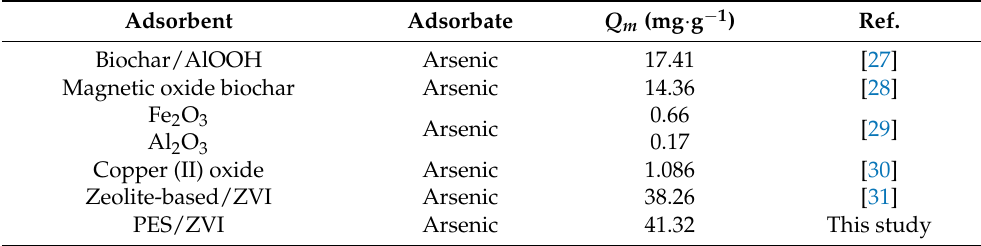
Table 6. The comparison of different adsorbents for the separation of arsenic.